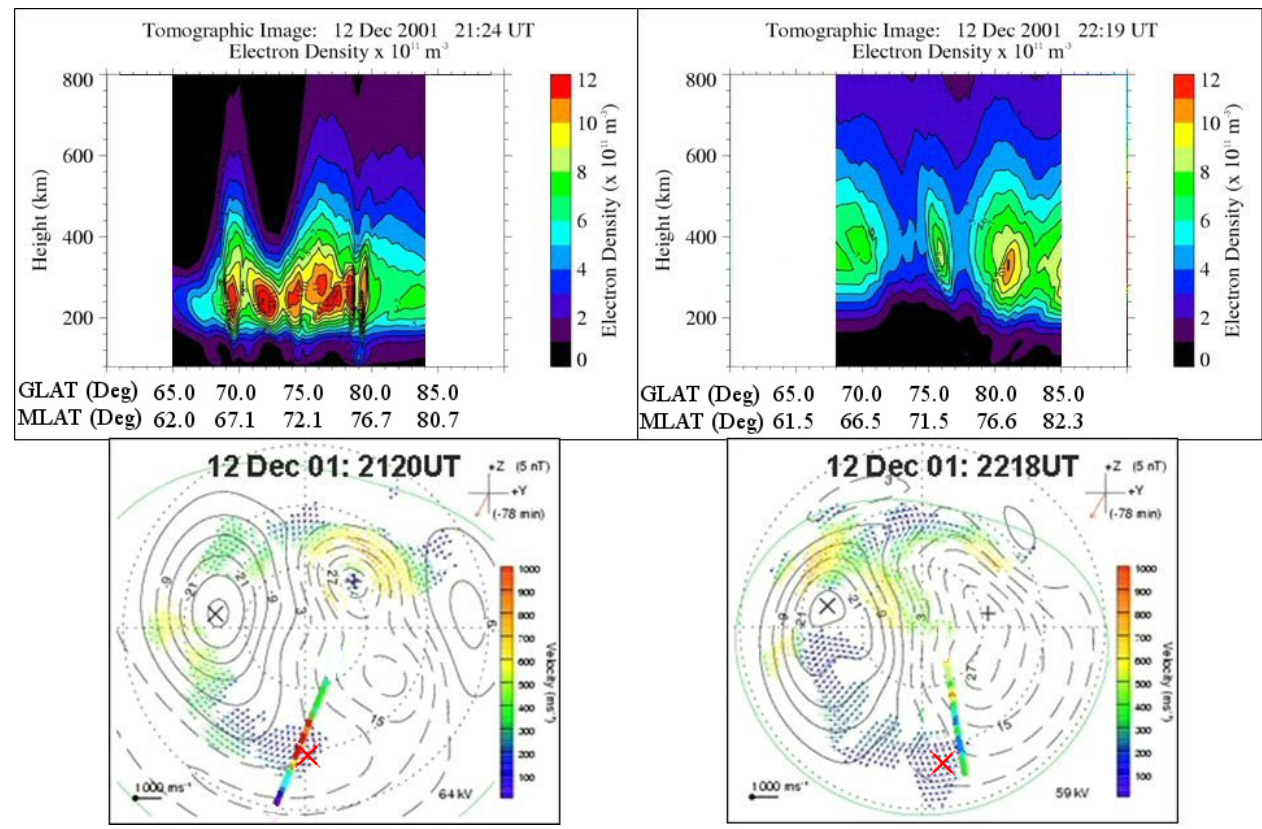
Fig. 5. Radiotomography reconstructions of electron densities for satellite passes that crossed a latitude of 75 ◦ N at 21:24UT (top left panel) and 22:19UT (top right panel), and corresponding SuperDARN electric potential patterns at 21:20UT (bottom left panel) and 22:18UT (bottom right panel). The multicoloured lines on the potential maps indicate the 350km intersections of the respective satellite trajectories, with the colours representing the peak F-region electron densities of the tomography images. The red crosses represent the position of the 30min running mean of the Spectral Width Boundary as inferred from the observations by beam 6 of the Hankasalmi SuperDARN radar at this